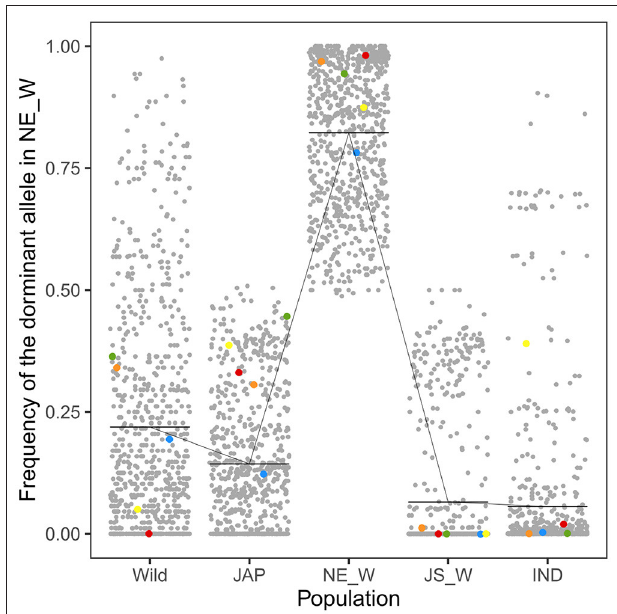
FIGURE 3 | Frequencies of the northeastern weedy rice-specific predominant alleles in wild rice (Wild), japonica rice (JAP), northeastern weedy rice (NE_W), Jiangsu weedy rice (JS_W), and indica rice (IND) populations. Each dot represents a SNP allele. The horizontal bars indicate the mean allele frequency in each population. The red, blue, yellow, green, and orange dots represent the alleles located in Os03g0122600 , Os10g0136150 , Os10g0155800 , Os11g0191300 , and Os08g0227200 , respectively. Their espression patterns were validated by